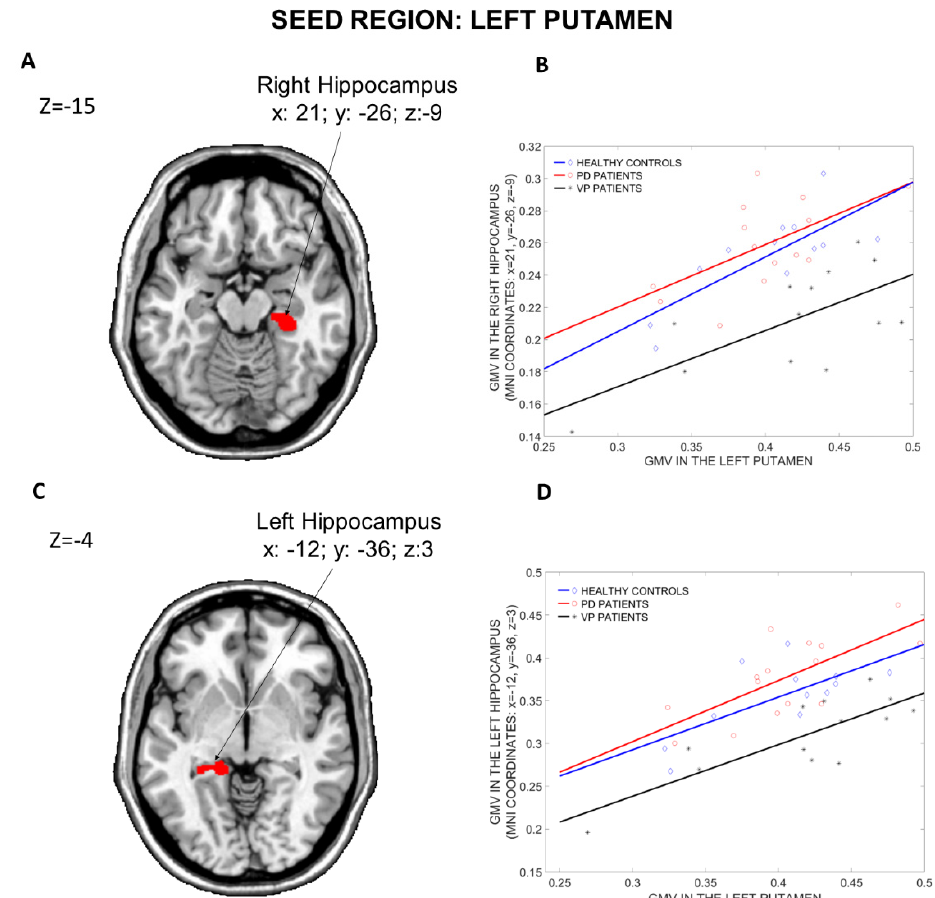
Figure 4. Group differences in the structural covariance of the Left Putamen. Brain maps are displayed using the neurological view. Panel ( A ): Voxels of the Right Hippocampus that expressed differences in the structural association across the three groups. Panel ( B ): Correlations between the mean gray matter volume of the Left Putamen and the regional gray matter volume extracted from a 4 mm-radius sphere centered on the peak voxels of the significant cluster (x: 21, y = − 26, z: − 9). Panel ( C ): Voxels of the Left Hippocampus that expressed differences in the structural association across the three groups. Panel ( D ): Correlations between the mean gray matter volume of the Left Putamen and the regional gray matter volume extracted from a 4 mm-radius sphere centered on the peak voxels of the signi fi cant cluster (x: − 12, y = − 36, z: 3). Blue diamonds represent HCs, red circles represent PD patients and black crosses represent VP patients. GMV: Gray Matter Volume; HCs: Healthy Controls; PD: Parkinson’s Disease; VP: Vascular Parkinsonism.